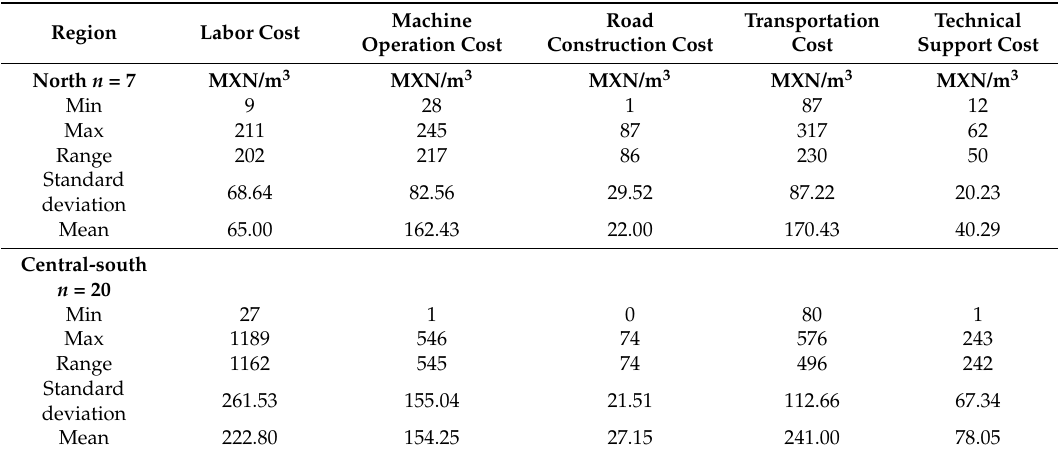
Table 16. Statistics parameters from sampled data according to cost and